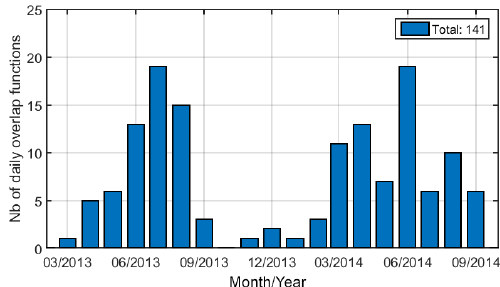
Figure 4. Success rate of the algorithm for 2 years of data.